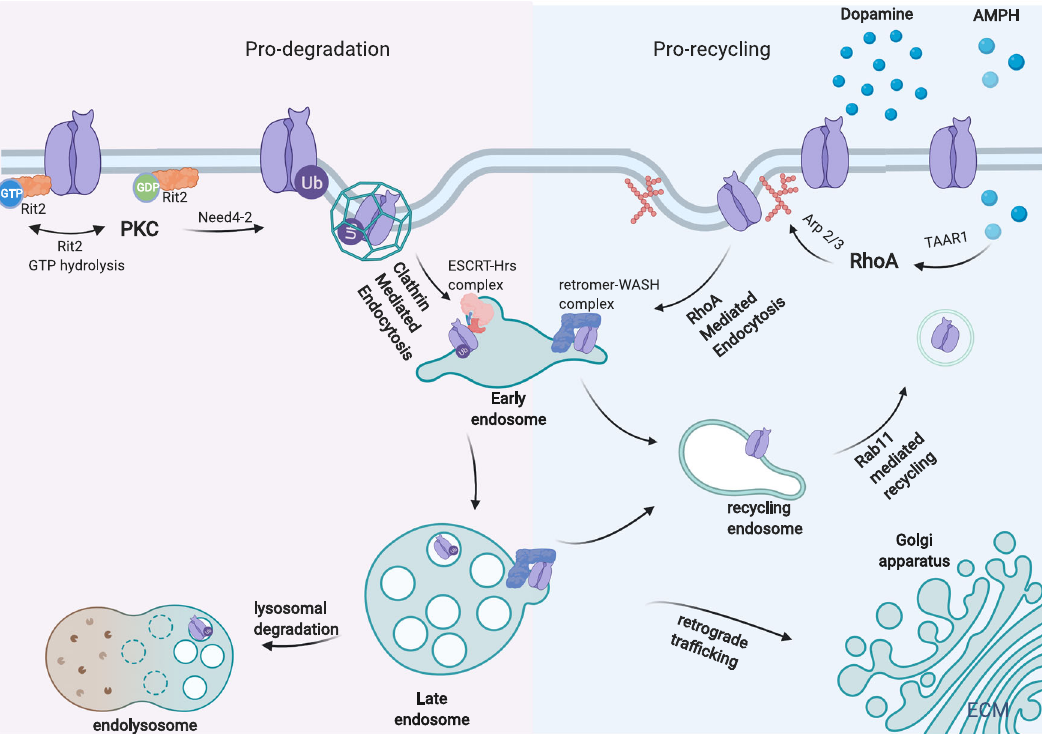
Fig. 1 Dopamine transporter surface expression is regulated through endocytic traf fi cking. RIT2-DAT association acts as DAT endocytic brake. PKC activation promotes the dissociation of RIT2 from DAT, enhances DAT ubiquitination by Nedd2-4, and targets DAT to clathrin- mediated endocytosis. Ubiquitinated DAT is recruited to ESCRT-Hrs complex which sorts DAT for lysosomal degradation. Conversely, DAT substrate activates intracellular effector TAAR1 and RhoA GTPase, which orchestrates actin polymerization through Arp2/3 near the plasma membrane and mediates clathrin-independent endocytosis. Substrate induced DAT internalization preferentially targets DAT to Rab11 mediated plasma membrane recycling, possibly through retromer-WASH (the endosomal cargo retrieval complex). This fi gure is created with